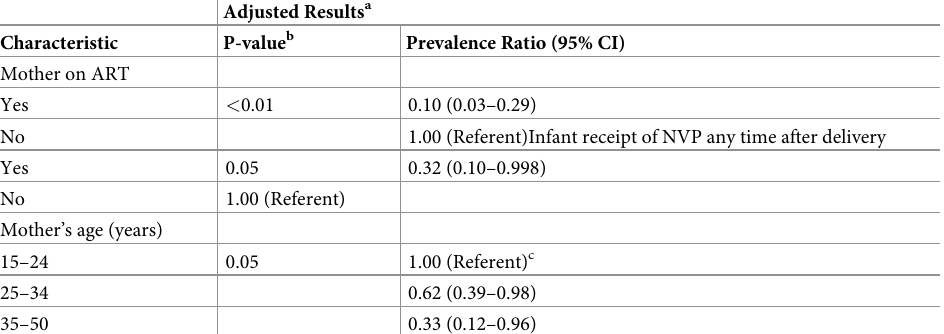
Table 3. Multivariable analysis of mother’s receipt of ART, infant’s receipt of NVP, and mother’s age with early mother to child transmission of HIV.